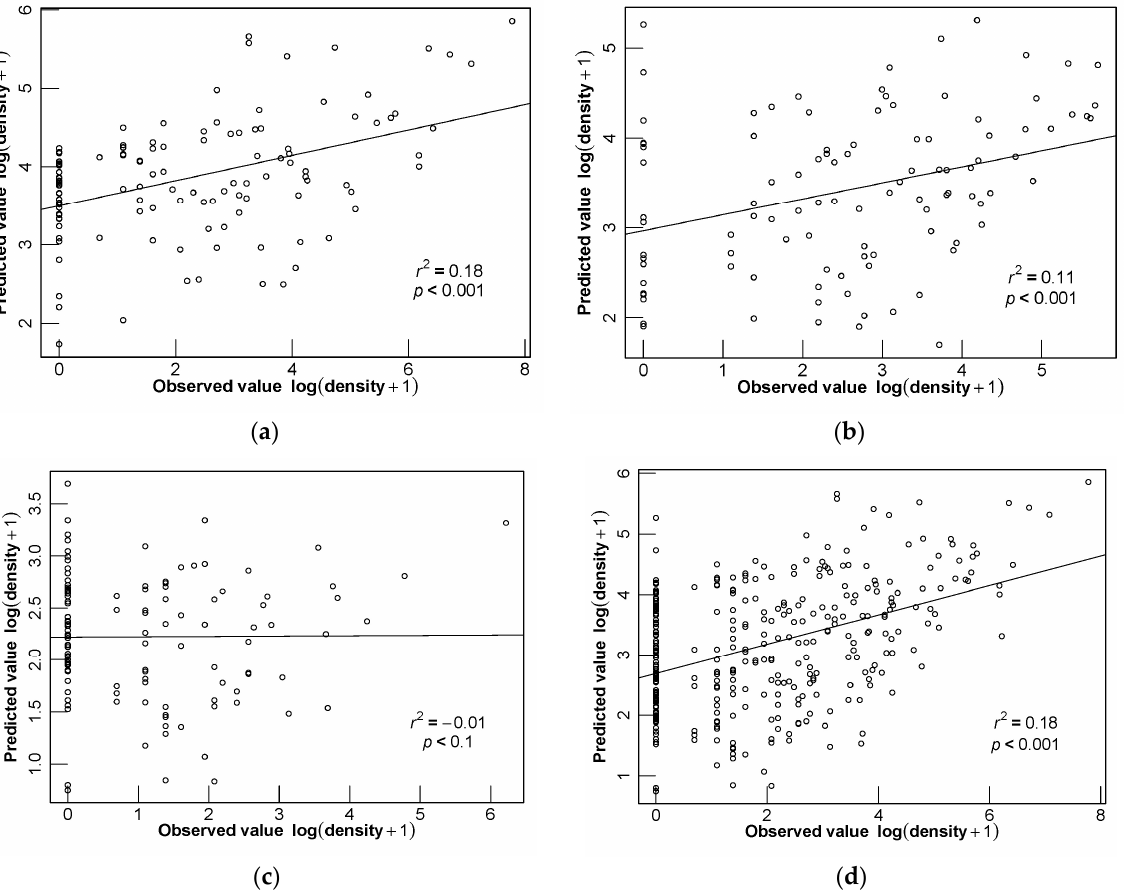
Figure 7. Scatter plots of observed and predicted densities of D. maruadsi in Yearly-GAM. ( a ) spring; ( b ) summer; ( c ) autumn; ( d ) whole